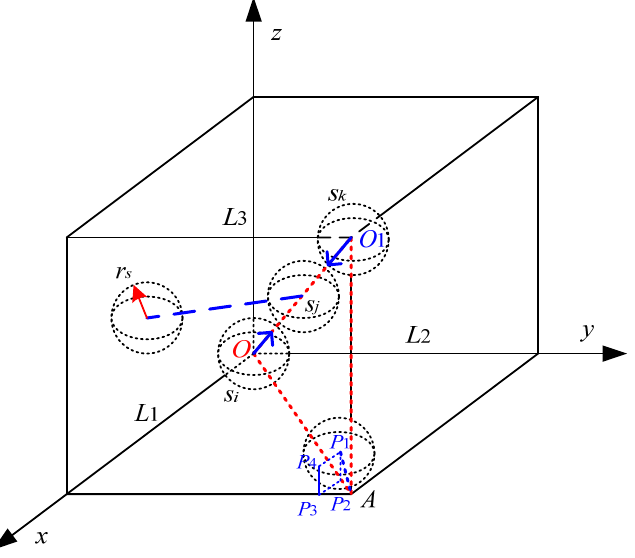
Figure 6. Virtual force analysis of end nodes. much larger than the gravity parameter. Suppose that the length ( x -axis), width ( y -axis), and height ( z -axis) of the spatial area are L 1 , L 2 , and L 3 , respectively; the three end nodes are O , O 1 , and P 1 , respectively; the position of node s j is located on the connecting